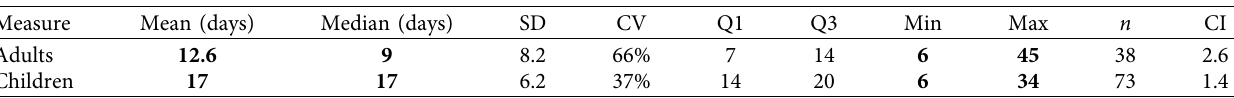
Table 8: Viral excretion of SARS-CoV-2: duration of positivity in days based on quantitative reverse transcription-polymerase chain reaction. Measure